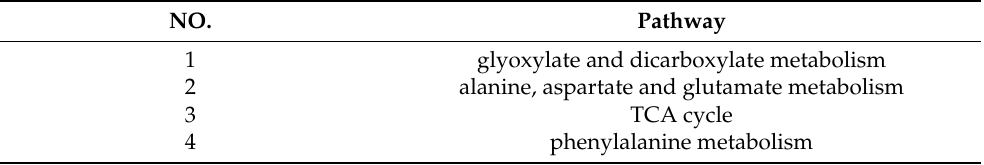
Table 6. METH-related differential metabolic pathways.